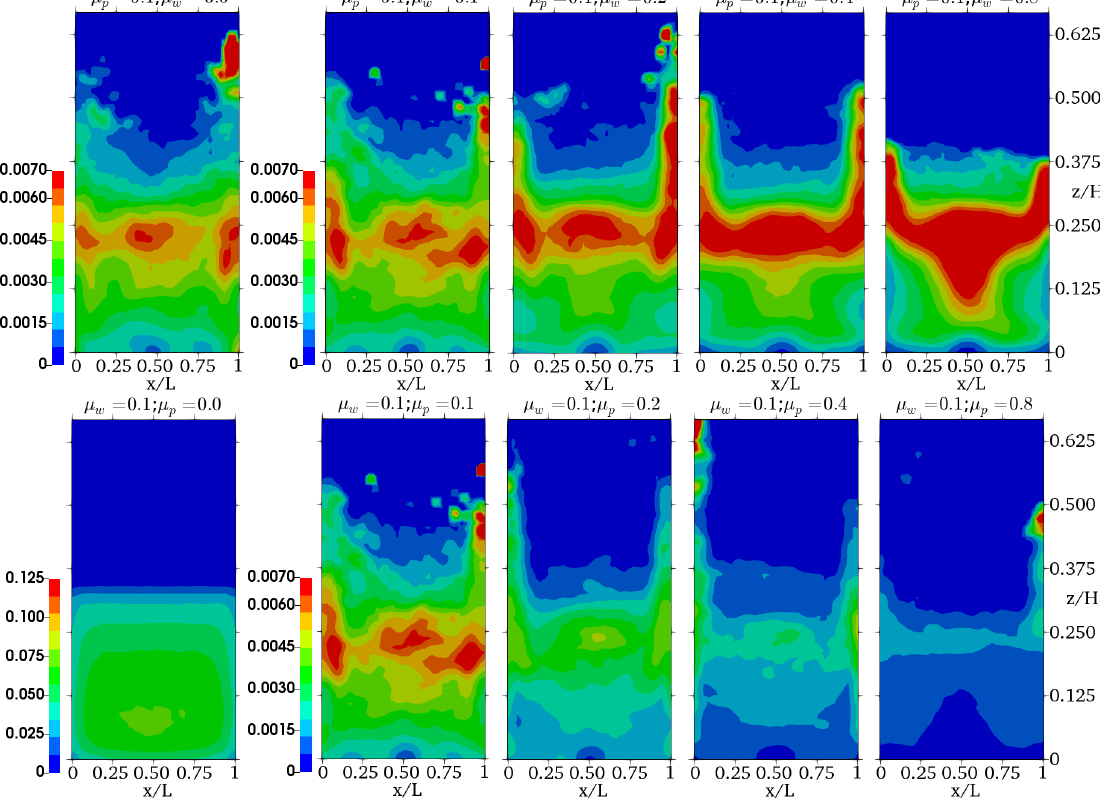
for different values of the f